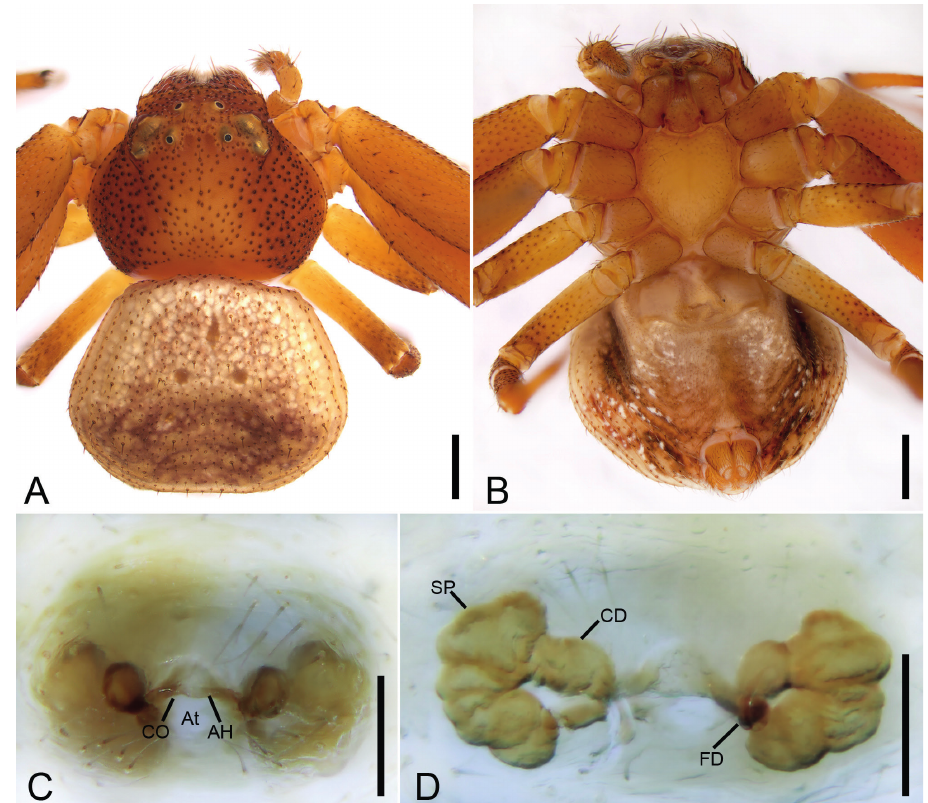
Figure 6. Ebelingia forcipata (Song & Zhu, 1993), female. A habitus, dorsal view B same, ventral view C epigyne, ventral view D same, dorsal view. Abbreviations: AH – anterior hood, At – atrium, CD – copulatory duct, CO – copulatory opening, FD – fertilisation duct, SP – spermatheca. Scale bars: 0.5 mm ( A, B ), 0.1 mm ( C, D